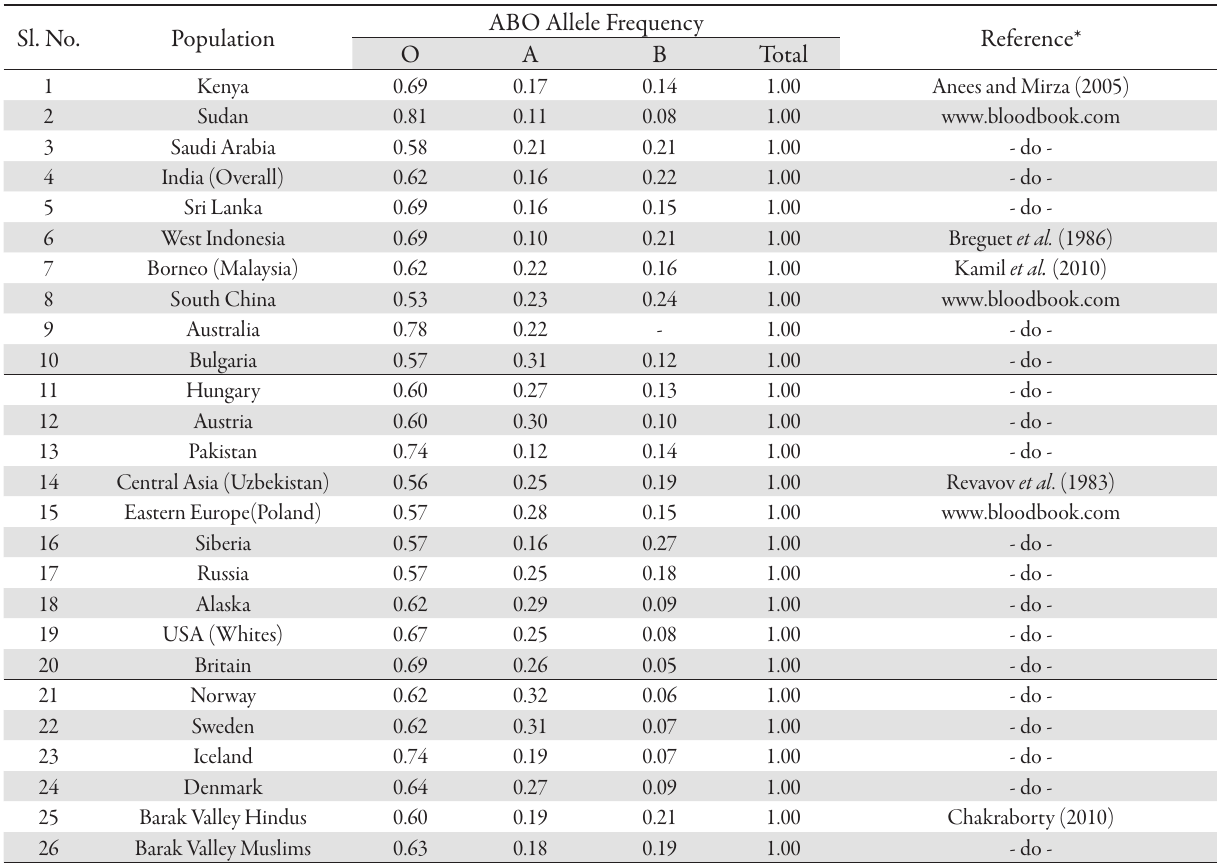
Tab. 1. Estimates of allele frequency of ABO gene in Barak Valley populations vis-a-vis other exotic nations enroute the journey of mankind from Africa Sl.